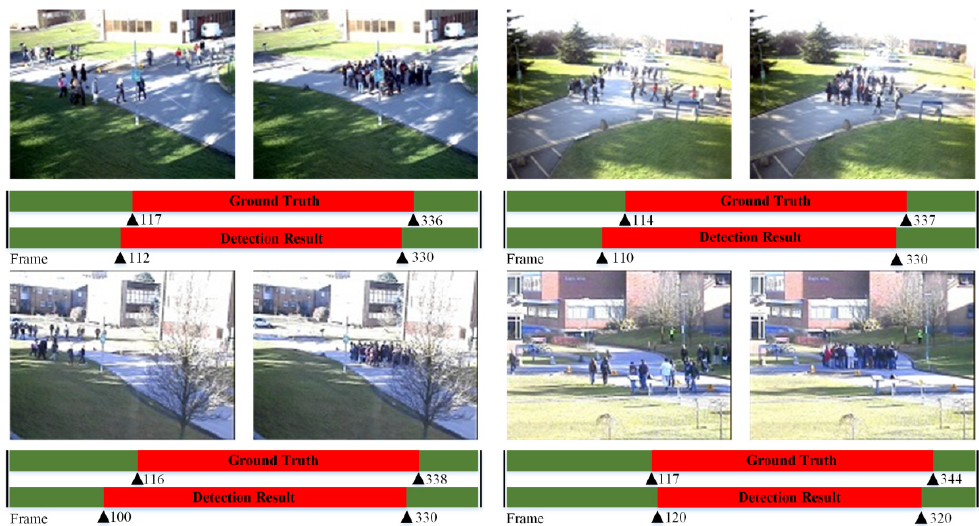
Figure 9. The detection results of DGG on the PETS2009 dataset. ( Upper-left ): view 1; ( Upper-right ): view 2; ( Bottom-left ): view 3; ( Bottom-right ): view 4.